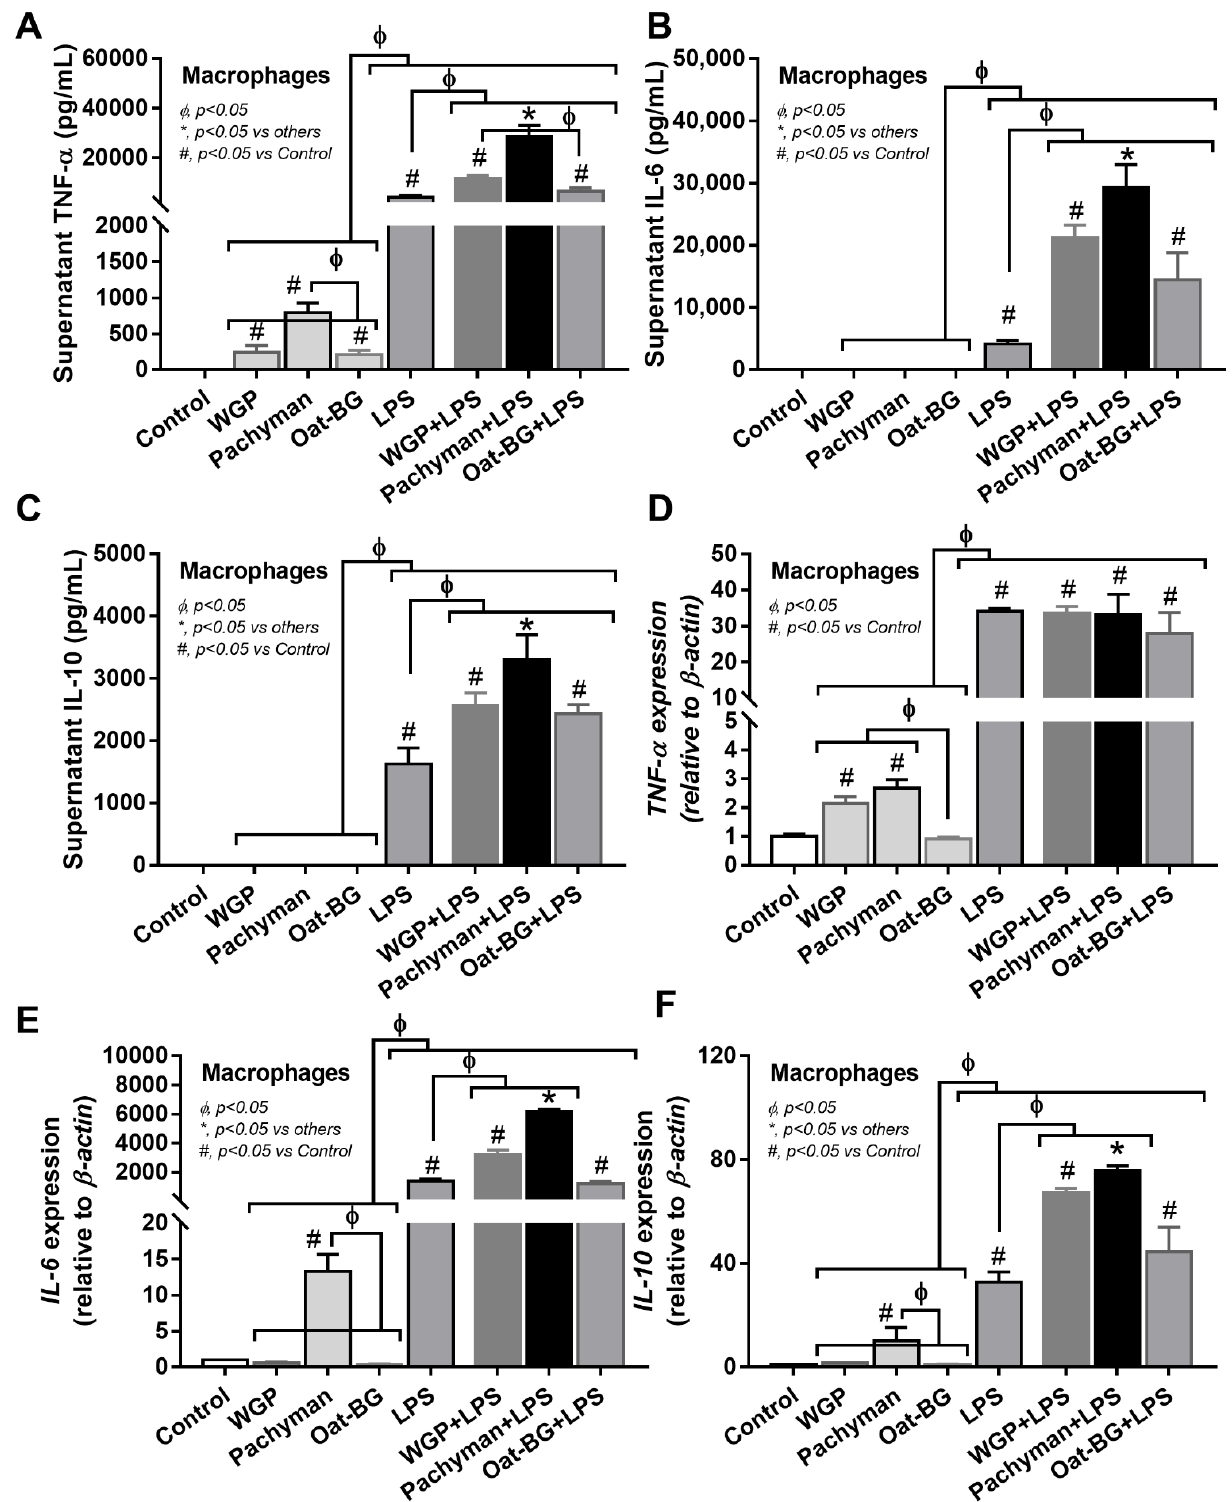
Figure 6. Characteristics of bone marrow-derived macrophages after 24 h of incubation in the control medium (Control) or control medium supplemented with whole-glucan particles (WGP), Pachyman, Oat glucans (Oat-BG), lipopolysaccharide (LPS), and LPS with the different glucans. Supernatant cytokines (TNF- α , IL-6, and IL-10) with gene expression ( A – F ) are shown ( n = 6–8/group). #, p < 0.05 vs. Control; *, p < 0.05 vs. other groups; φ , p < 0.05 vs. the indicated group as calculated by ANOVA with Tukey’s analysis. Independent triplicate experiments were